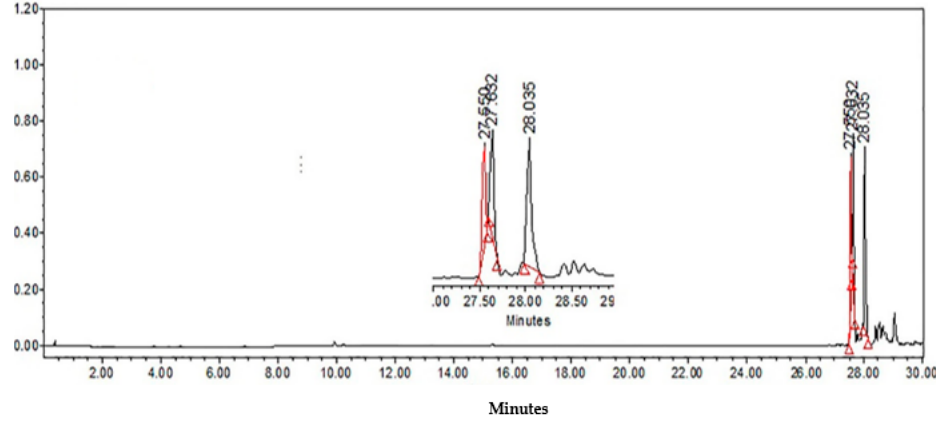
Figure 3. HPLC chromatogram at 280 nm of sub-fraction Ltc1-F3. Table 3. 1 H and 13 C NMR data of nor 3 ′ -demethoxyisoguaiacin ( 1 , 600 and 150 MHz, CD 3 OD).